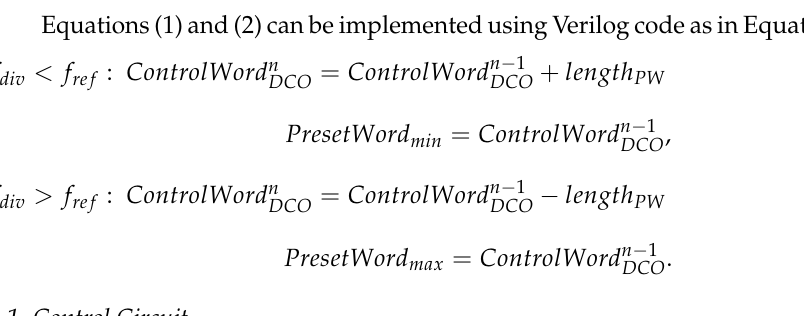
Figure 2. Locking process ( a ) TS-ADPLL, ( b )